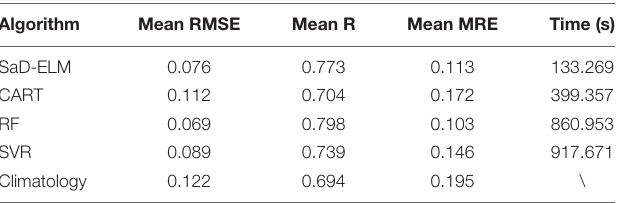
TABLE 6 | Mean RMSE, R, MRE, and model running time of different prediction models (lead time = 1 d). Algorithm